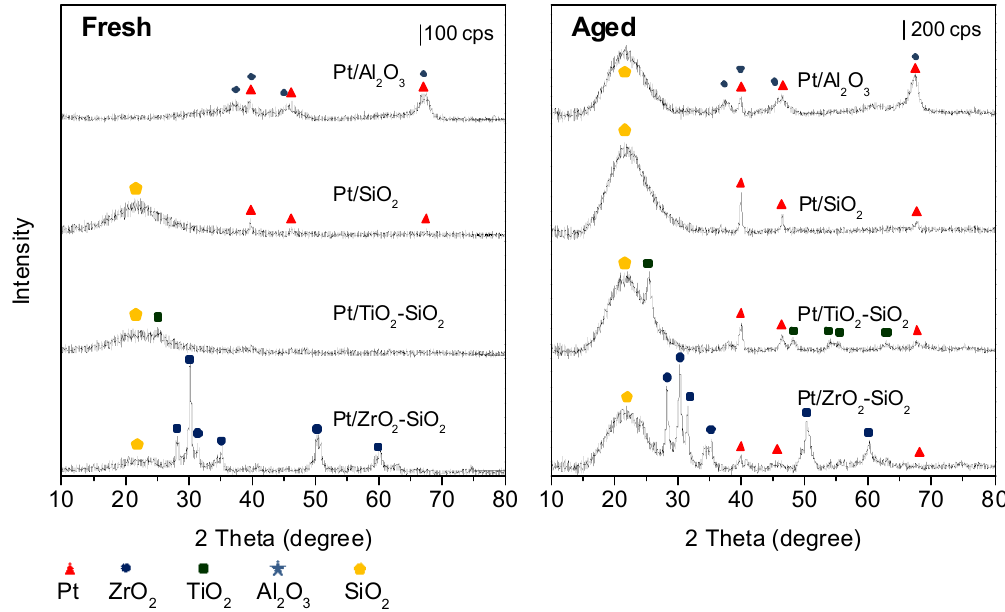
Figure 1. XRD patterns of Pt/Al hydrothermally aged state. The large SiO catalysts were due to the quartz powder physically mixed with the catalysts for the reactor evaluation.